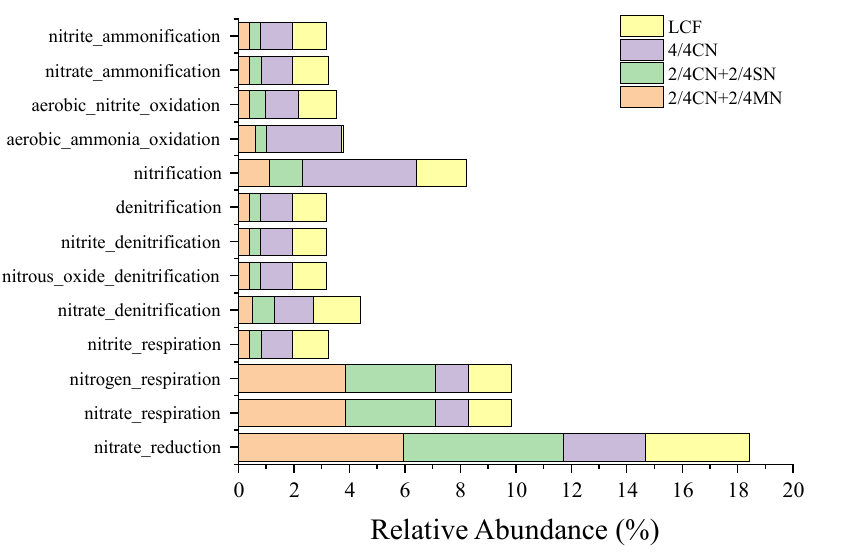
Figure 3. Potential N-cycling functioning of all treatments predicted by FARPOTAX. CN: chemical nitrogen; MN: swine manure nitrogen; SN: maize straw nitrogen; LCF: local conventional fertilization.